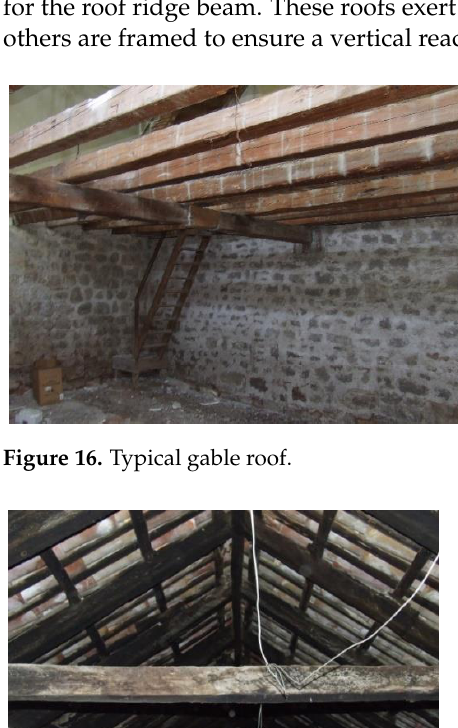
Figure 17. Typical gable roof. Figure 17. Hipped roof